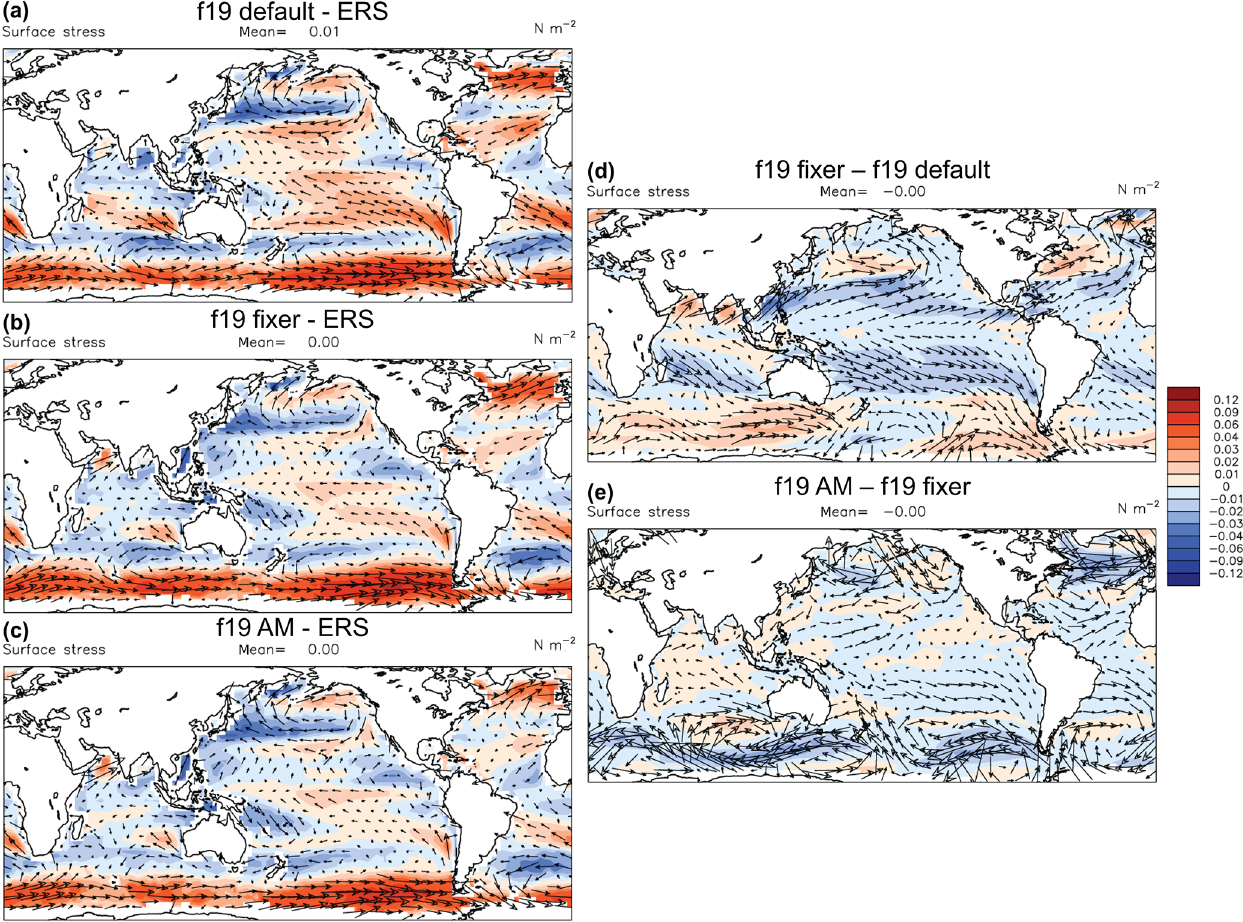
Figure 9. Impact of the AM correction and fixer in F2000 simulations. Panels (a) , (b) , and (c) show maps of surface wind-stress vector differences (arrows) and wind-stress magnitude differences (colours) between F2000 simulations with CAM–FV at 1.9 ◦ × 2.5 ◦ resolution (f19) and a climatology obtained from satellite scatterometer observations (ERS; Quilfen et al., 1999). Panel (a) shows the annual-mean climatological bias in the f19 control integration, (b) for an f19 simulation with the AM fixer only, and (c) for an f19 simulation with both the AM correction and AM fixer. Panels (d) and (e) show the same fields, but for the differences between the simulation with the fixer only and the control and between the simulation with both the fixer and correction and that with the fixer only. The colour scale for all plots is on the right of (d) and (e) . These plots were produced with the AMWG diagnostics package developed by the Atmospheric Model Working Group of the University Corporation for Atmospheric Research and the National Center for Atmospheric